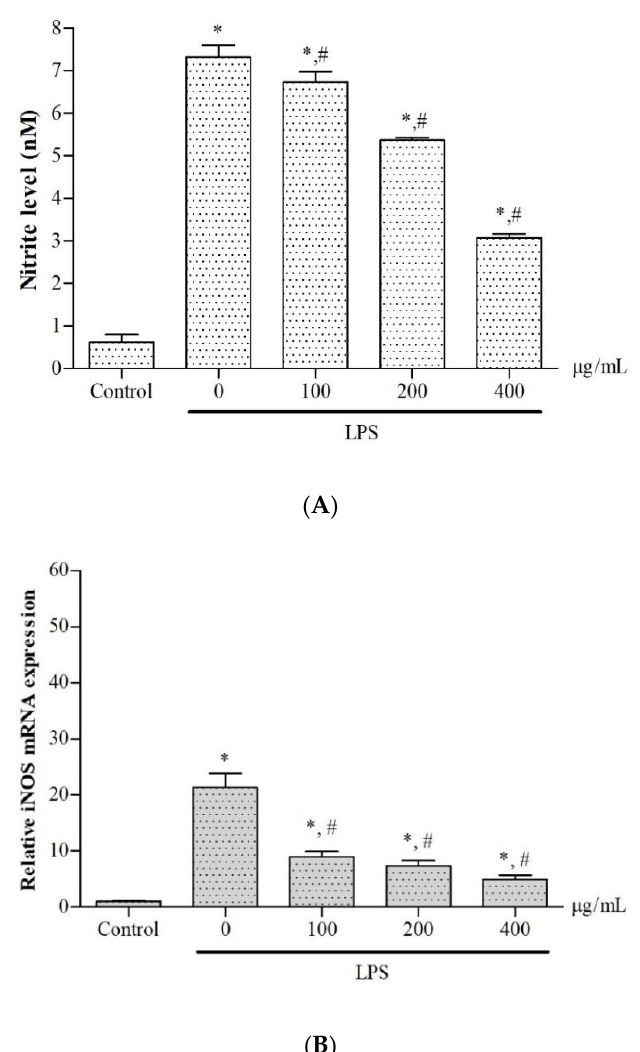
Figure 4. Levels of NO • production ( A ) and iNOS gene expression ( B ) in LPS-induced RAW264.7 macrophages after treatment with 50% ethanolic extract of P. odoratum Lour . cv. Pakphai leaves (100, 200 and 400 μg/mL) for 24 h. Data obtained from three independent experiments are expressed as mean + SEM values. Accordingly, * p < 0.05 was considered significant when compared to cells with- out LPS induction; # p < 0.05 was considered significant when compared to LPS-induced cells with- out the extract treatment. Abbreviations: iNOS = inducible nitric oxide synthase, LPS = lipopolysac- charide, NO • = nitric oxide radical, SEM = standard error of the mean values.